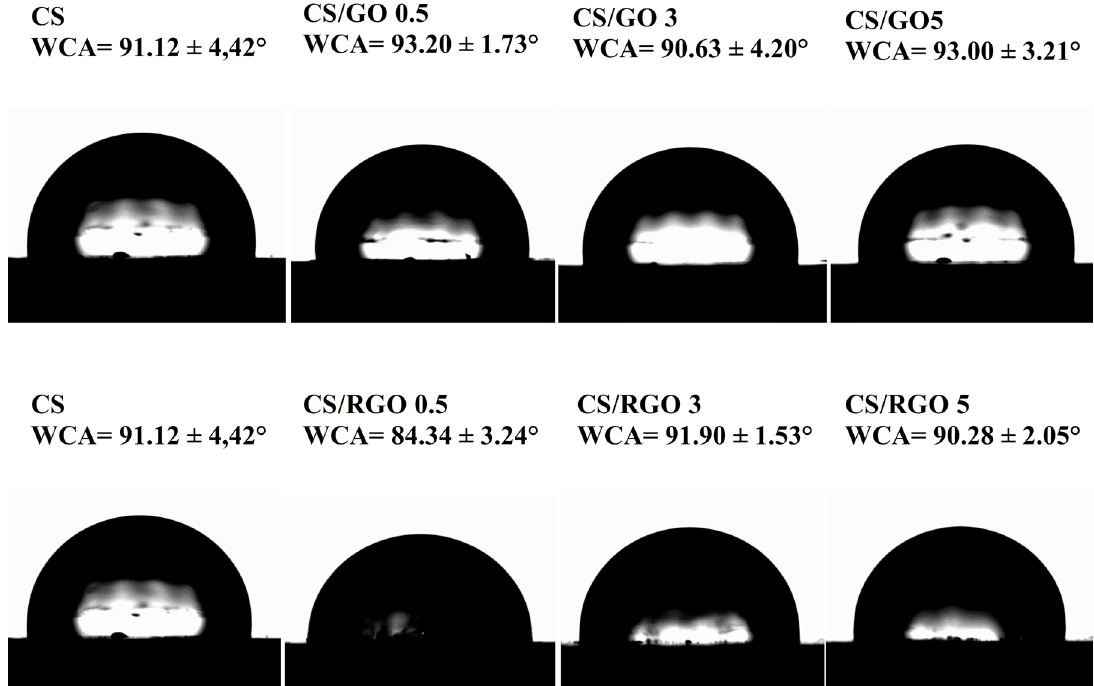
Figure 7. Water contact angle of chitosan membranes as a function of wt% of graphene fillers.